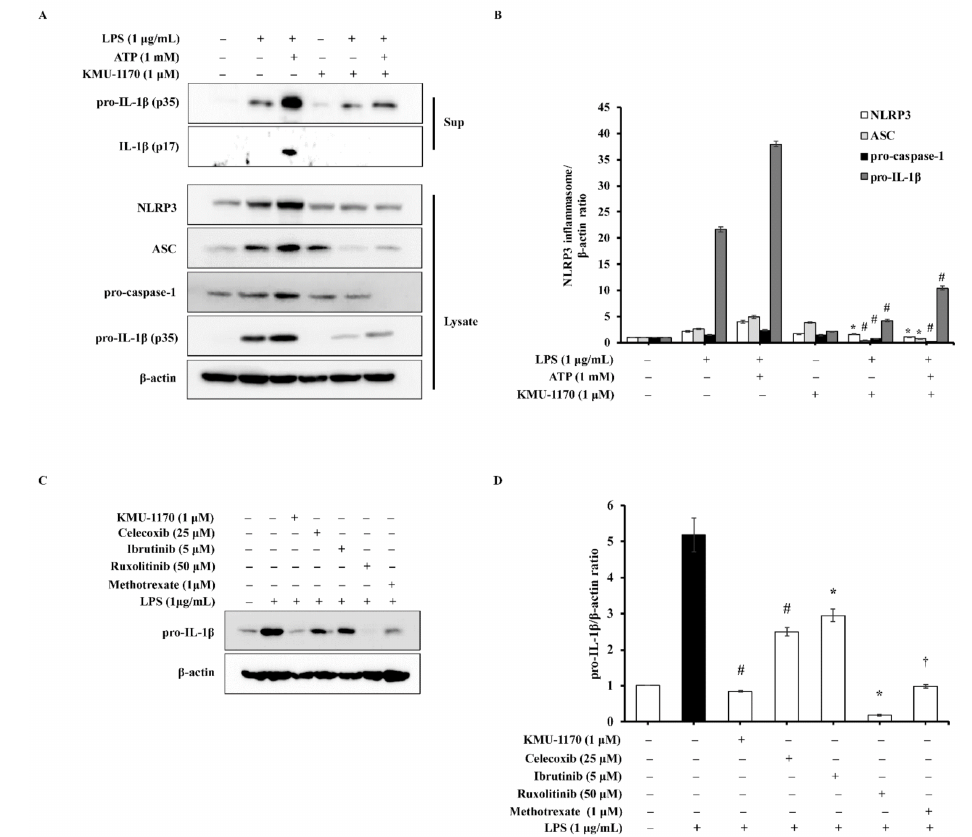
Figure 5. Inhibitory effect of KMU-1170 on LPS-induced activation of NLRP3 inflammasome and anti-inflammatory potentiality of KMU-1170 in THP-1 cells. ( A ) Cells were differentiated into macrophages for 24 h using PMA (100 nM). And then the cells were treated with LPS (1 µ g/mL) and/or ATP (1 mM) for 6 h after pretreatment with 1 µ M KMU-1170 for 1 h. Cell lysate (Lysate) and media supernatant (Sup) were isolated and used to measure the protein expression levels of pro-IL-1 β and IL-1 β for the Sup as well as NLRP3, ASC, pro-caspase-1, pro-IL-1 β , and β -actin for the Lysate by Western blot analysis. ( B ) Image-J software was used to analyze the relative optical density of the NLRP3, ASC, pro-caspase-1, and pro-IL-1 β band in the Lysate. ( C ) Cells were differentiated into macrophages for 24 h using PMA (100 nM). And then the cells were treated with LPS (1 µ g/mL) for 6 h after pretreatment with KMU-1170 (1 µ M), celecoxib (25 µ M), ibrutinib (5 µ M), luxolitinib (50 µ M), and metotrexate (1 µ M) for 1 h. Whole cell lysates were isolated and used to measure the protein expression levels of pro-IL-1 β and β -actin by Western blot analysis. ( D ) Image-J software was used to analyze the relative optical density of the pro-IL-1 β band. † p < 0.05, * p < 0.01, and # p < 0.001 compared to LPS